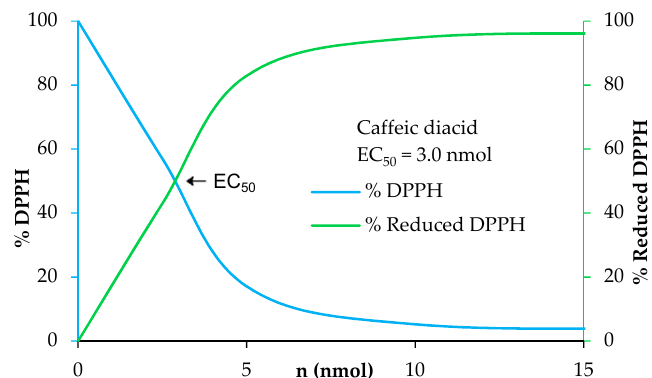
Figure 7. Determination of the antiradical activity of caffeic diacid. Table 7. Antiradical